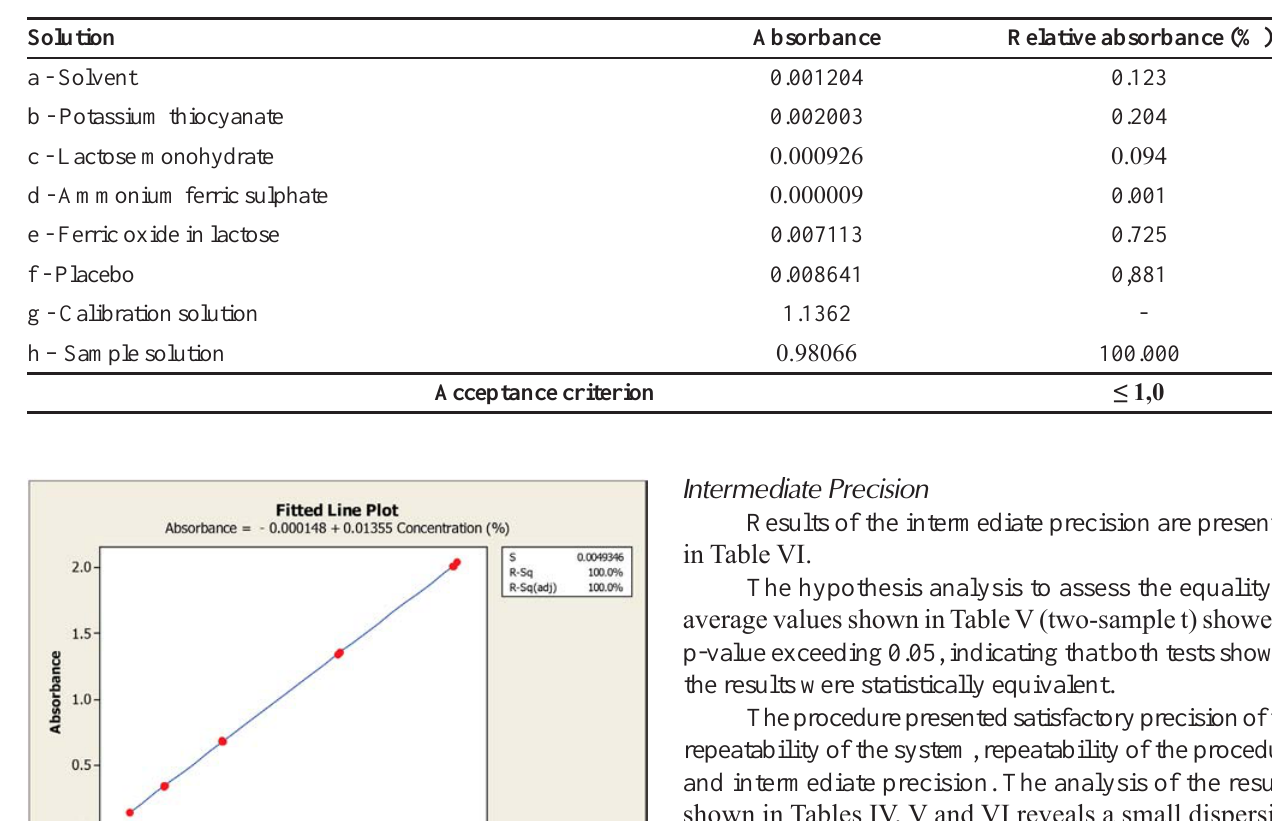
TABLE II - Absorbance of the solutions at 480 nm relative to the sample solution for verification of the specificity of the procedure